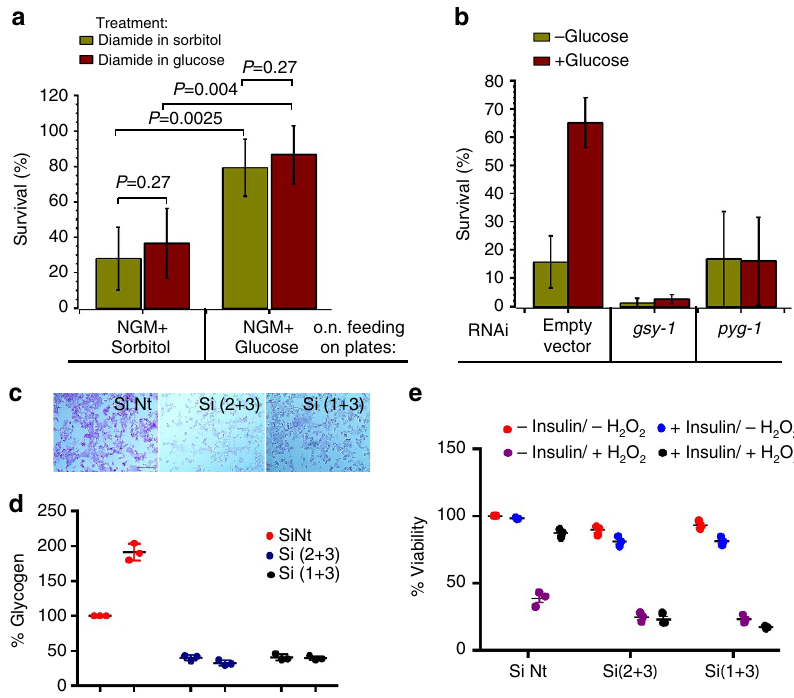
Figure 3 | Glycogen protects C. elegans and hepatocytes against oxidative stress. All graphs show the average survival ± s.d. from at least three independent experiments. Approximately 50 worms were used per condition per each experiment. ( a ) Stored glucose metabolite(s), not glucose in the media, protects C. elegans from oxidants. L4 stage animals grown on NGM plates þ sorbitol or þ glucose for 20h were picked and transferred to M9 containing sorbitol and diamide (green bars) or glucose and diamide (red bars). ( b ) Glycogen storage is required for C. elegans protection against oxidants. N2 worms fed on NGM plates seeded with E. coli HT115 harbouring either empty plasmid vector or plasmid vectors expressing gsy-1 or pyg-1 RNAi. L4 stage animals were transferred to NGM plates with sorbitol (green bars) or with glucose (red bars) for 20h and then treated with 150mM diamide (e.v.: n ¼ 130, P ¼ 0.00001; gsy-1 : n ¼ 155, P ¼ 0.105; pyg-1 : n ¼ 180, P ¼ 0.479). P values were calculated with respect to control animals in the same experiment using Student’s t-Test. See also Supplementary Fig. 2. ( c ) PAS staining of HepG2 cells after glycogen synthase 2 knockdown by siRNA. SiNt, non target siRNA; Si(2 þ 3), combination of siRNA GYS2.2 and GYS2.3; Si(1 þ 3), combination of siRNA GYS2.1 and GYS2.3. Scale bar 100 m m. ( d ) Relative glycogen content in HepG2 cells treated with insulin and GYS-2 siRNA. Error bars represent s.d. of three independent experiments. ( e ) Glycogen protects hepatocytes against peroxide. HepG2 cell were depleted of glycogen synthase 2 by siRNAi and then incubated with 50 m M H 2 O 2 for 30min. Cell viability was assayed after 24h. Insulin was added to a final concentration of 25 m M. Error bars represent s.d. of three independent